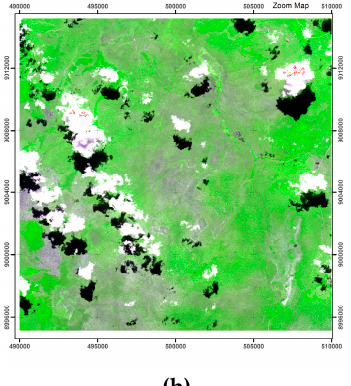
Figure 2. The RapidEye ABG map ( a ) for a sample centered on the 9° S 38° E confluence point and ( b ) the satellite image false colour composite (Shortwave Infrared (SWIR), Near-Infrared (NIR), Red). Cloud and cloud shadow are masked out in the first stages of the pre-processing, then image segments are assigned AGB values using the model developed using random forest.